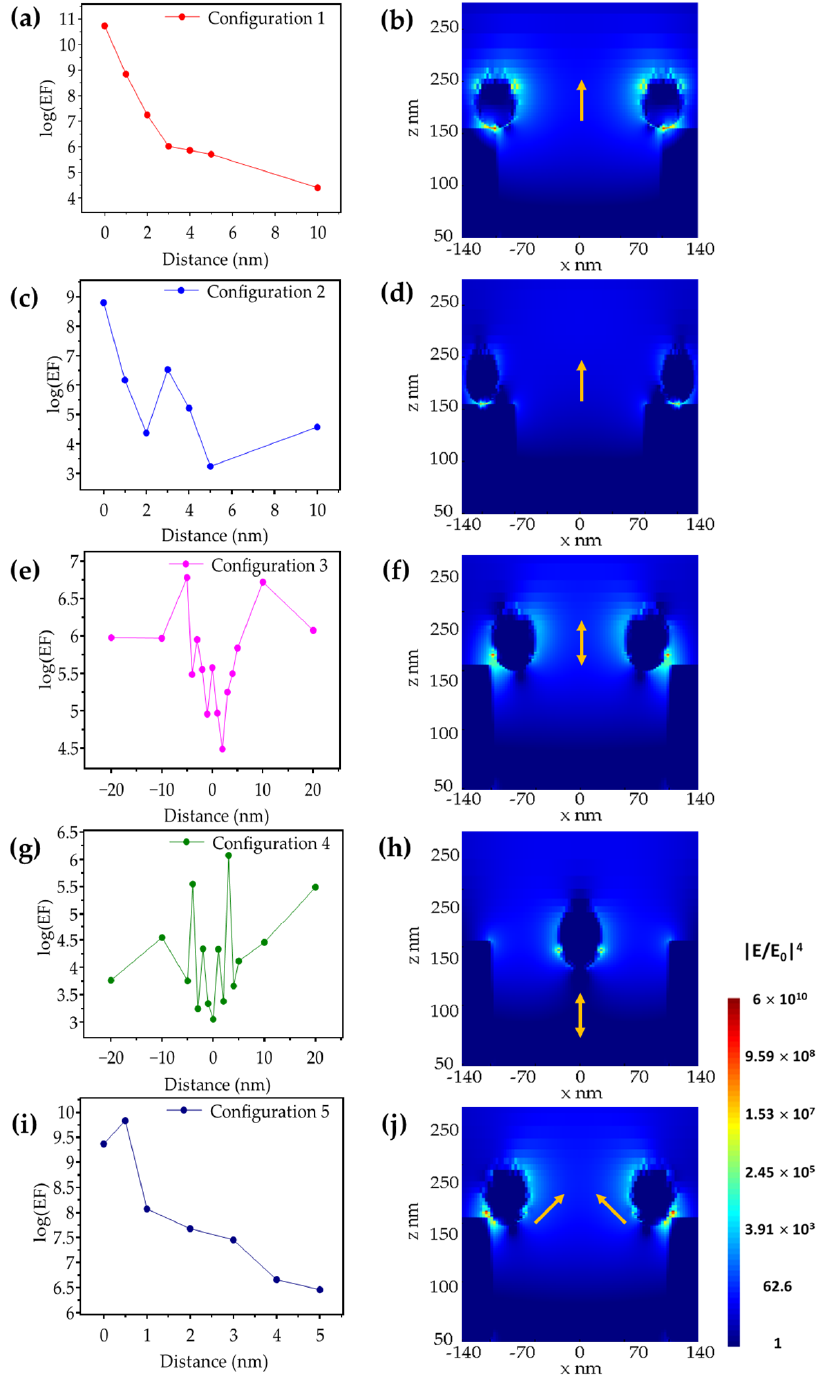
Figure 7. Ag-NP-on-Ag-NHA G SERS values for different distances (left column) and e-field distributions (| E / E 0 | 4 ) of the electromagnetic Raman enhancement factor for the position with the highest G SERS (right column) for ( a , b ) Configuration 1, ( c , d ) Configuration 2, ( e , f ) Configuration 3, ( g , h ) Configuration 4, and ( i , j ) Configuration 5. Yellow arrows indicate the direction in which the particles are displaced.